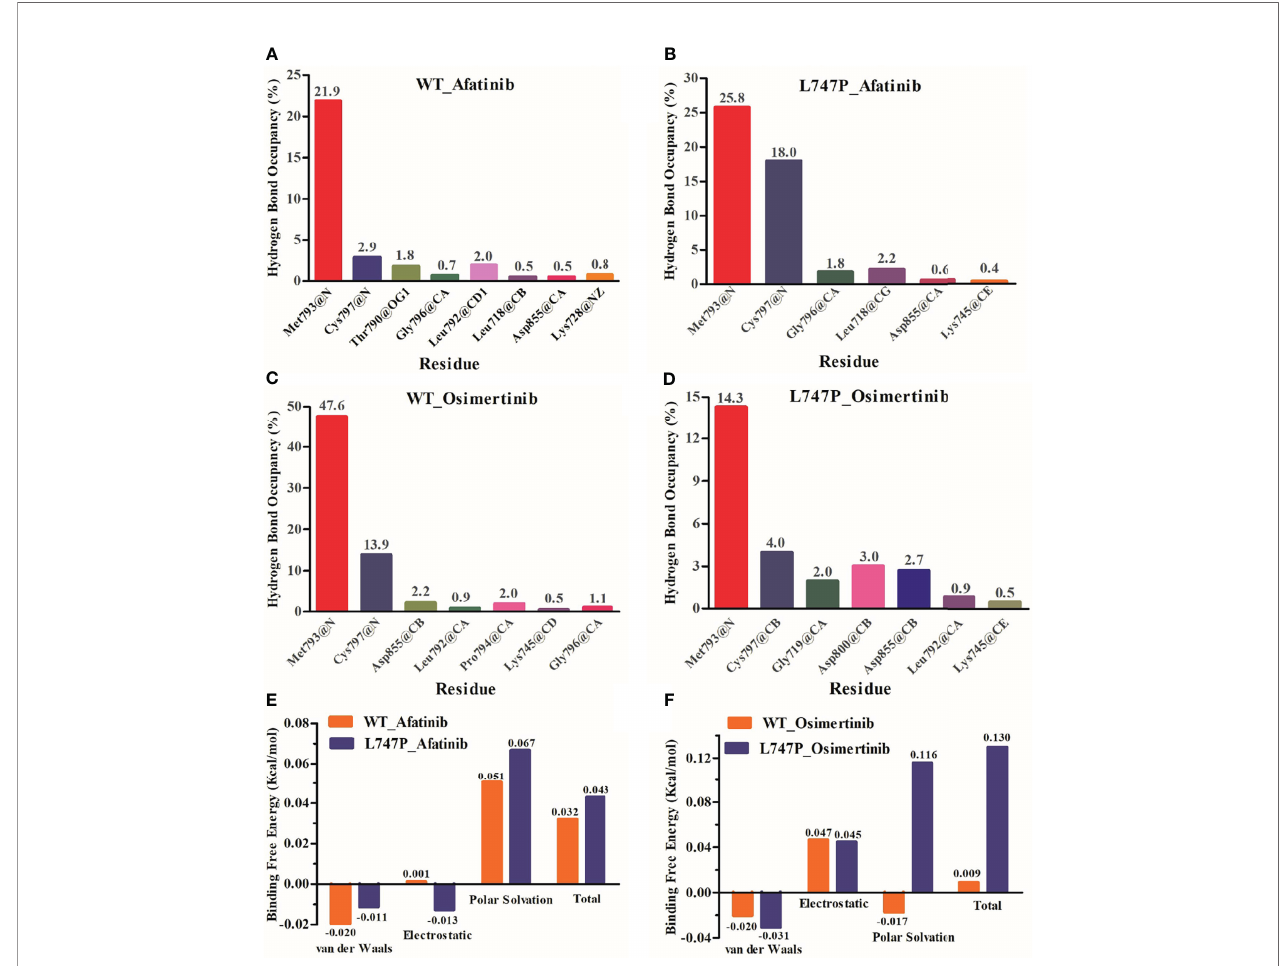
FIGURE 3 | Binding af fi nity to afatinib in EGFR wild type (A) and p.L747P conformation (B) by hydrogen bond occupancy analysis. Binding af fi nity to osimertinib in EGFR wild type (C) and p.L747P conformation (D) by hydrogen bond occupancy analysis. Dynamics calculations for binding free energies with afatinib (E) and osimertinib (F) when substituting proline for leucine.